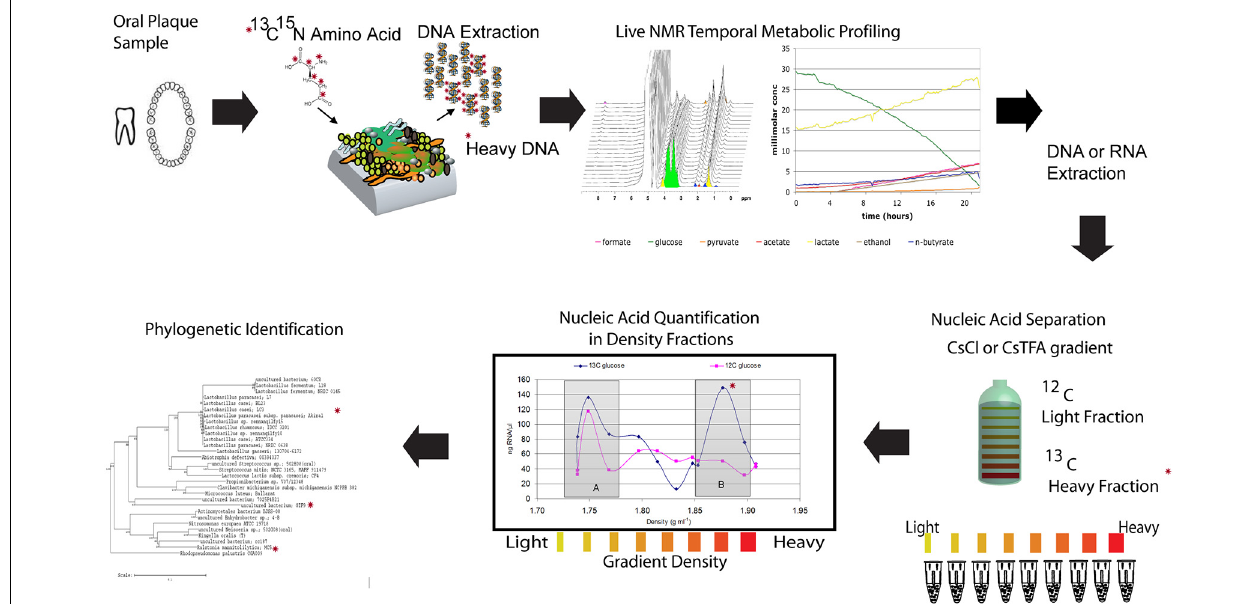
FIGURE 4 | Illustration of a NMR-SIP experimental procedure. Combining nucleic acid based Stable Isotope Probing (SIP) with in situ non-invasive Magnetic Resonance Spectroscopy (MRS) to link real-time organic acid production measurements and the specific bacterial species active in oral biofilms.Theexperimentalprocedureinvolvesincubatingplaquesamplesfrom healthy juvenile human subjects with isotopically labeled carbon sources